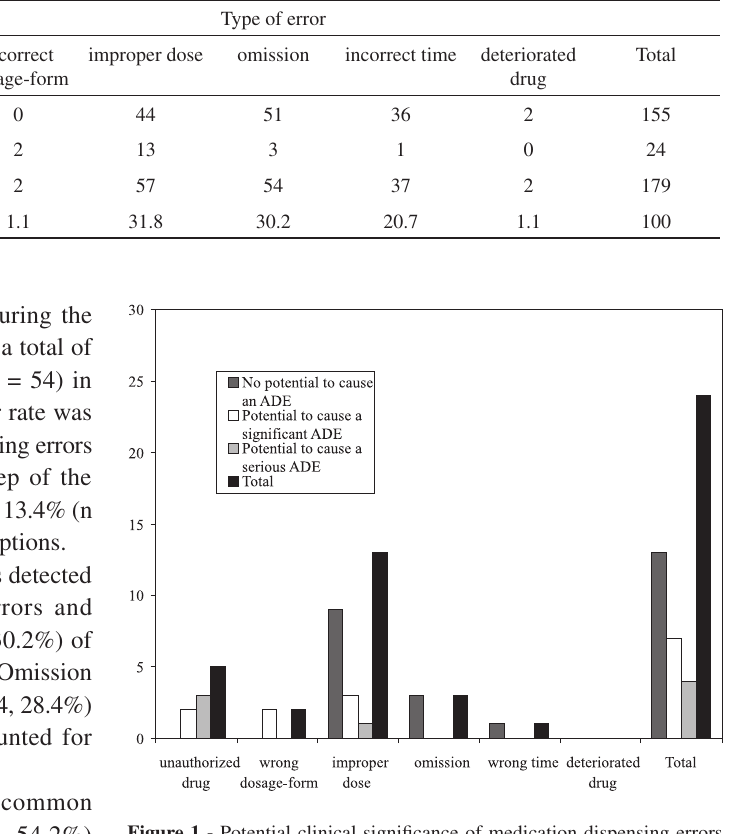
Figure 1 - Potential clinical significance of medication dispensing errors detected by